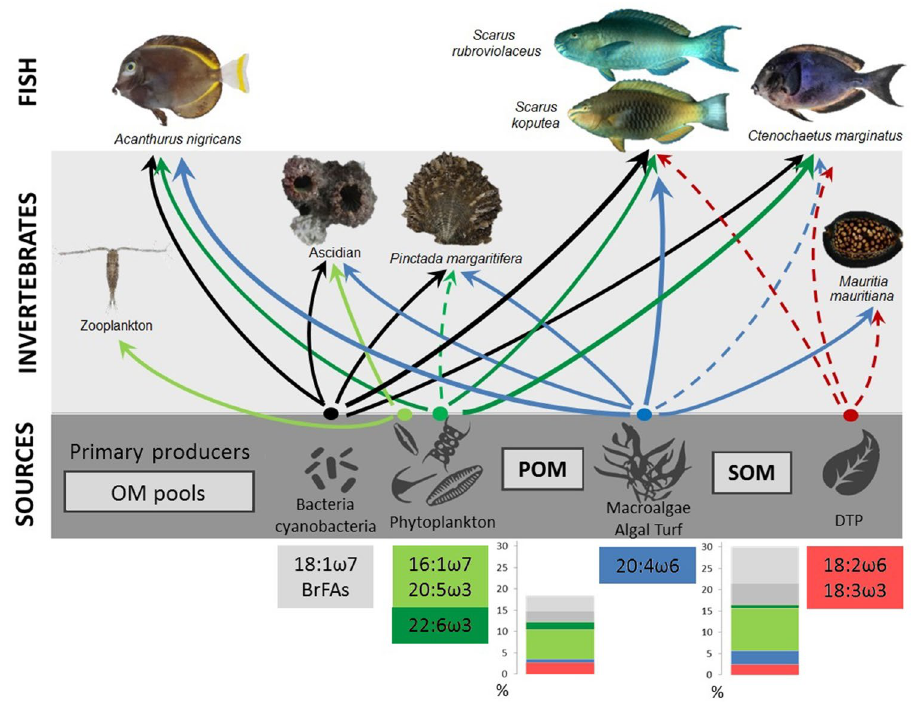
Figure 6. Schematic view of the integration of main OM sources by primary consumers, through fatty acid trophic markers. The relative importance of such integration is indicated by arrows (from dotted lines for minor role, to thick lines for important role). POM: particulate organic matter, SOM: sedimentary organic matter, DTP: detrital terrestrial plant material. For OM pools (POM and SOM), the % indicate the relative importance of primary producers (bacteria, phytoplankton, DTP etc.) assessed by major FAs trophic